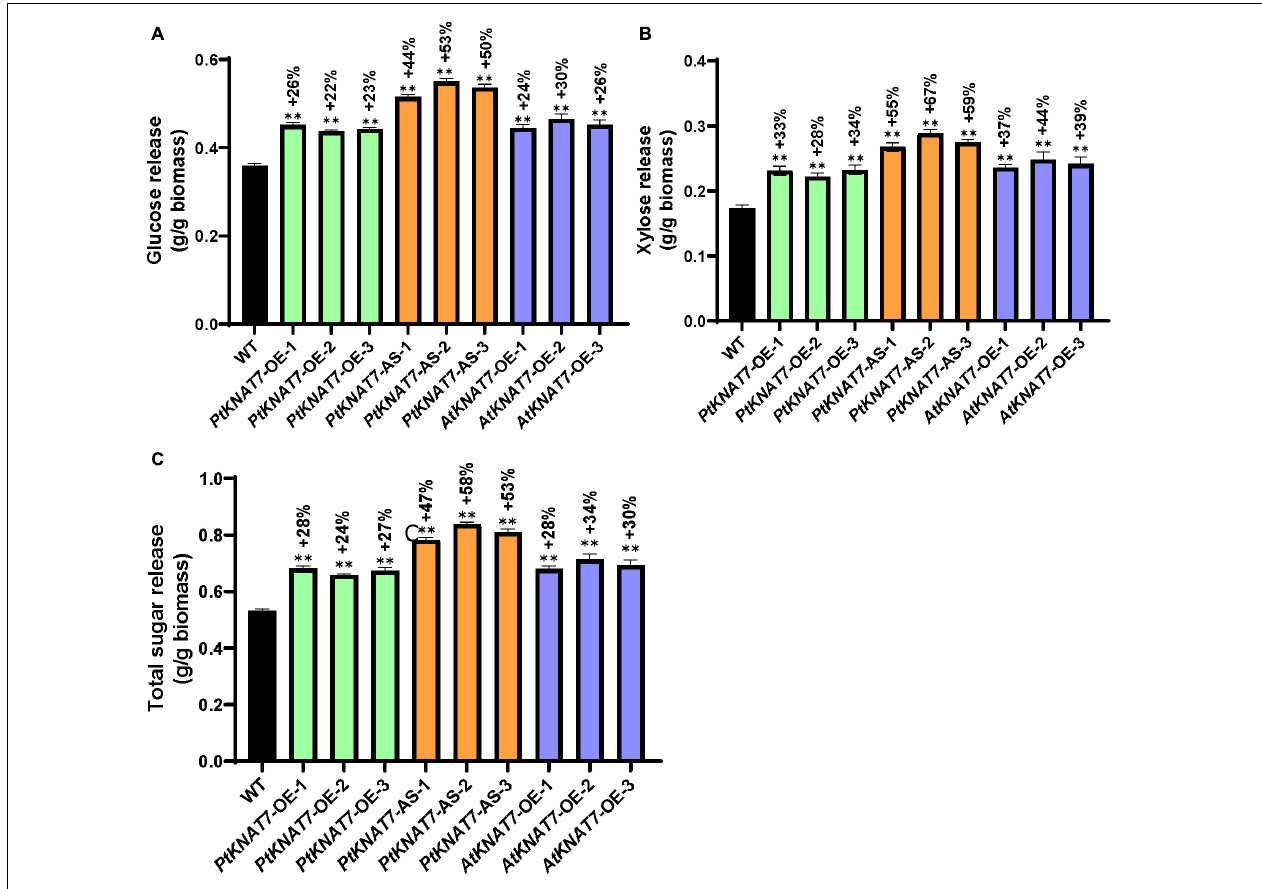
FIGURE 6 | Saccharification yield of three PtKNAT 7 -OE, PtKNAT7 -AS, and AtKNAT7 -OE lines. (A) Glucose released, (B) xylose released, and (C) total sugars released from all the three independent KNAT7 transgenic lines of poplars. Significant differences were observed when compared to WT controls, P -value <